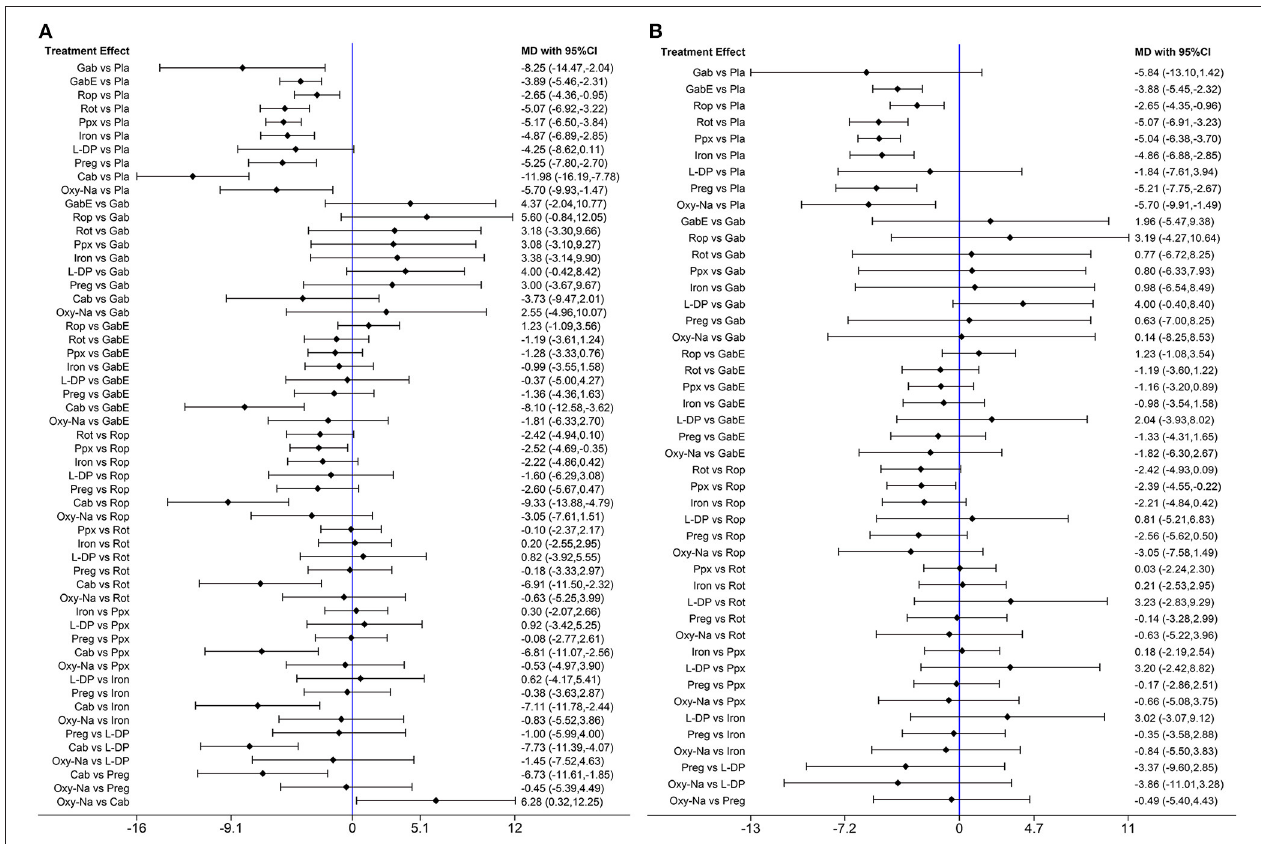
FIGURE 3 | (A) Forest plots of pairwise meta-analysis for all included drugs. (B) Forest plots of pairwise meta-analysis for the remaining drugs after excluding cabergoline. (Gab, Gabapentin; GabE, Gabapentin enacarbil; L-DP, Levodopa; Rot, Rotigotine; Ppx, Pramipexole; Cab, Cabergoline; Rop, Ropinirole; Preg, Pregabalin; Oxy-Na, Oxycodone-naloxone; Pla,